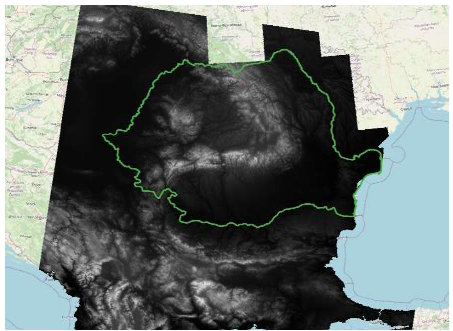
Figure 11. Digital terrain model for Romania (QGIS) .